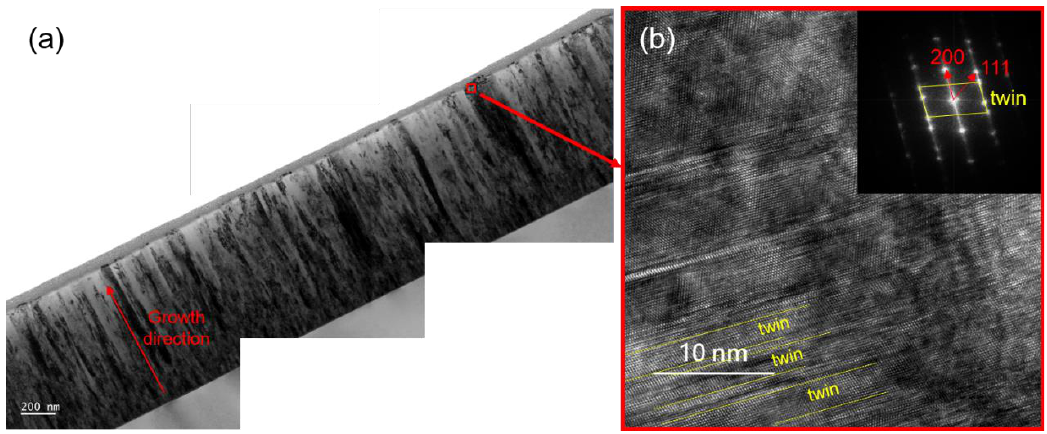
Figure 2. ( a ) Cross-sectional TEM images of SH, and ( b ) HRTEM image of nanotwin in SH and the corresponding FFT pattern.